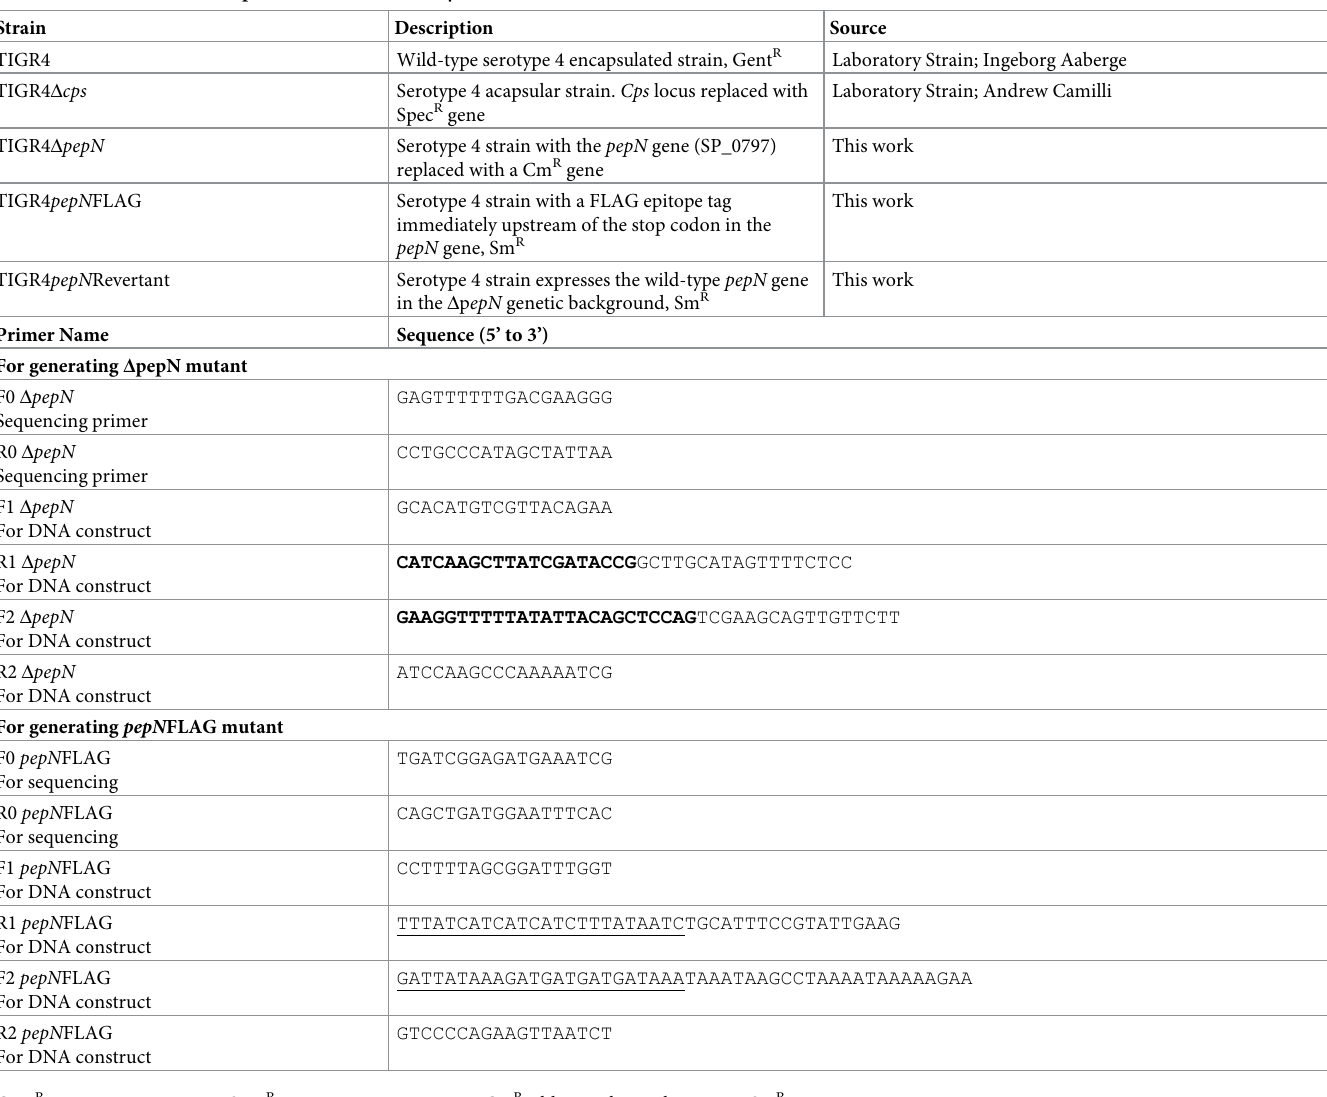
Table 1. Relevant strains and primers used in this